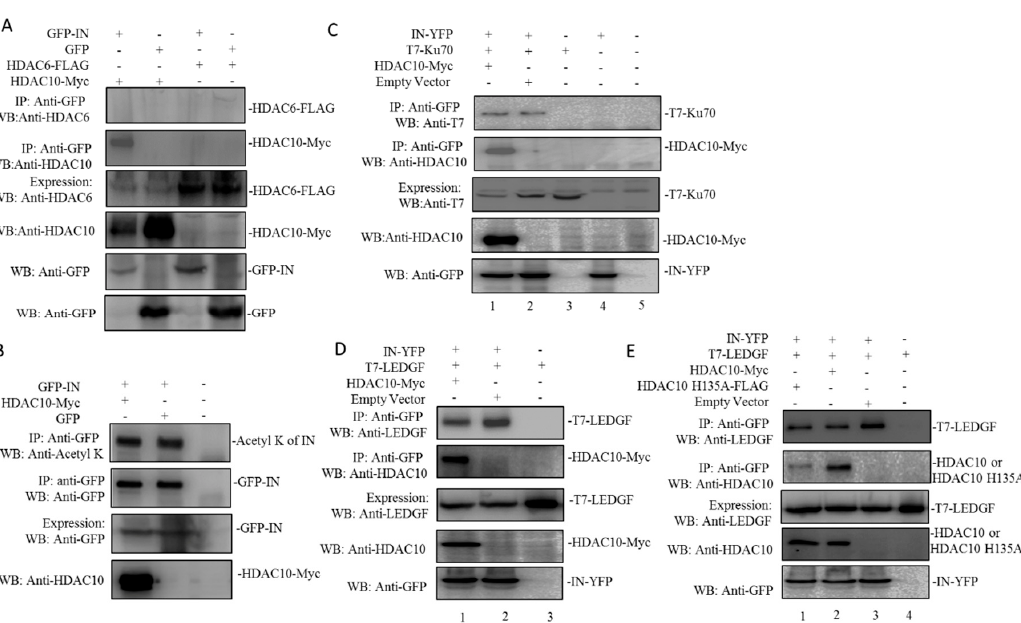
Figure5. Thee ff ectsofHDAC10ontheinteractionbetweenHIV-1INandcellularproteinsLEDGF / p75or KU70. ( A ) HIV-1 IN interacts with HDAC10 but not HDAC6. GFP or GFP tagged HIV-1 Integrase was co-expressed with HDAC10 or HDAC6 in 293T cells. Cells were subjected to co-IP using anti-GFP antibody and bound HDAC6 or HDAC10 was detected by anti-HDAC10 or anti-HDAC6 antibody. ( B ) The interaction of HDAC10 and HIV-1 Integrase does not change the lysine acetylation state of HIV-1 Integrase. GFP or GFP-IN and HDAC10 co-transfected 293T cells were subjected to co-IP analysis by using anti-GFP antibody and the bound GFP-IN was detected by anti-acetyl K antibody or anti-GFP antibody. ( C ) IN-YFP was co-expressed with T7-Ku70 and / or HDAC10-Myc in 293T cells. Cells were subjected to co-IP analysis by using anti-GFP antibody and bound T7-Ku70 or HDAC10-Myc was detected by WB using anti-T7 or anti-HDAC10 antibody. ( D , E ) IN-YFP was co-expressed with T7-LEDGF and / or HDAC10wt / H135A in 293T cells. Cells were subjected to co-IP analysis by using anti-GFP antibody and bound T7-LEDGF or HDAC10-Myc was detected by WB using anti-T7 or anti-HDAC10 antibody. All the above expressions of HDAC10-Myc, HDAC10-H135A, IN-YFP, T7-Ku70, or T7-LEDGF were detected by WB using anti-HDAC10, anti-GFP, or anti-T7 antibody. Panels A – E show the representative WB image from two independent